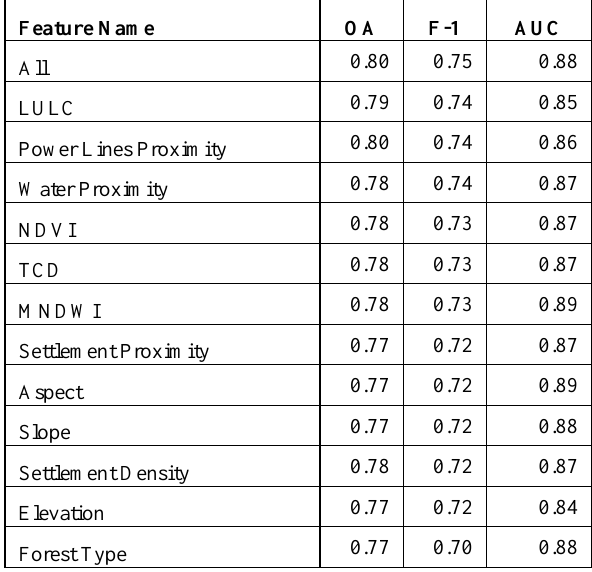
Table A1 . Leave-one-out results of the ANN.